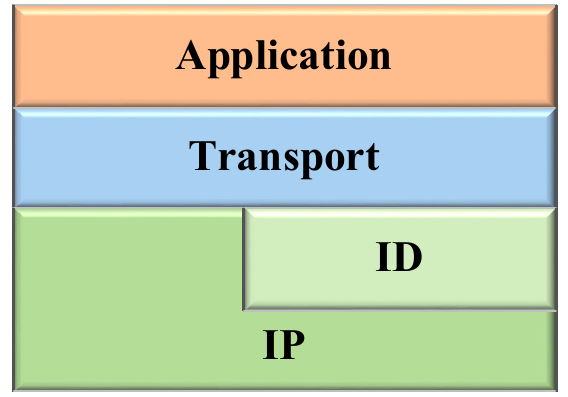
Figure 1. The protocol stack of ICN.